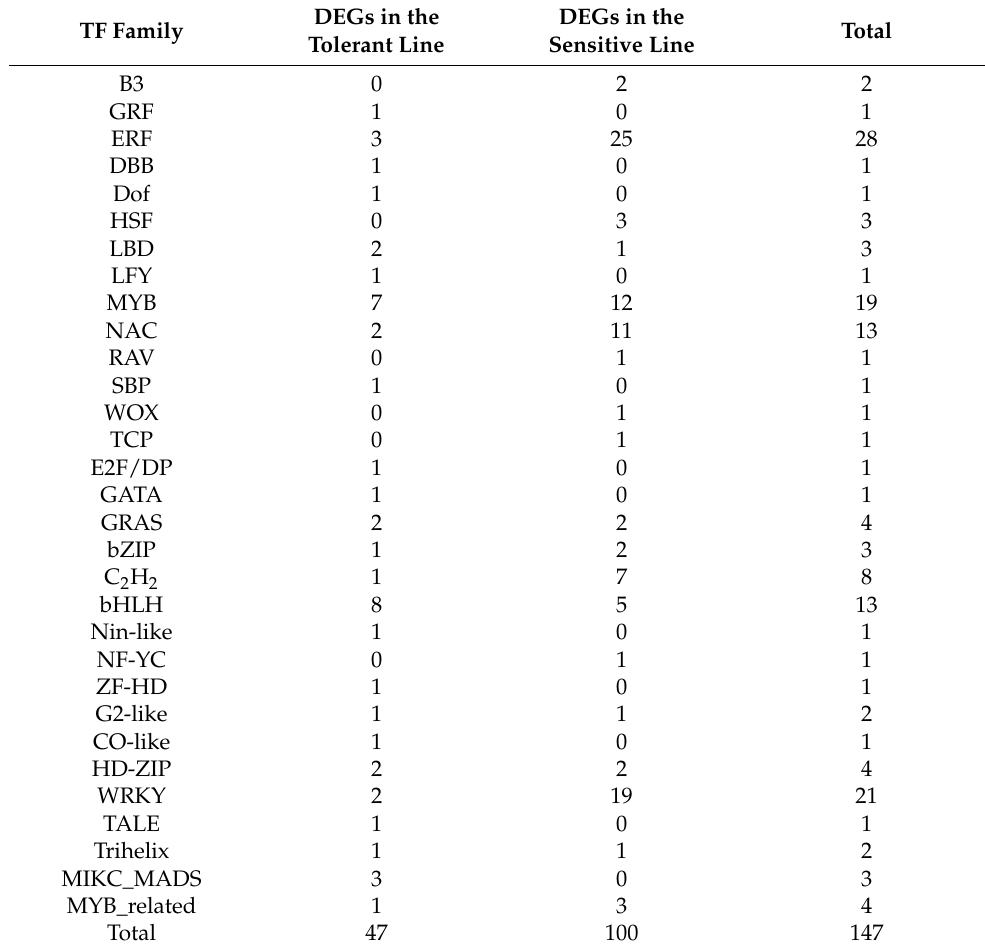
Table 1. Transcription factor gene families identified from 2237 DEGs in maize under cold